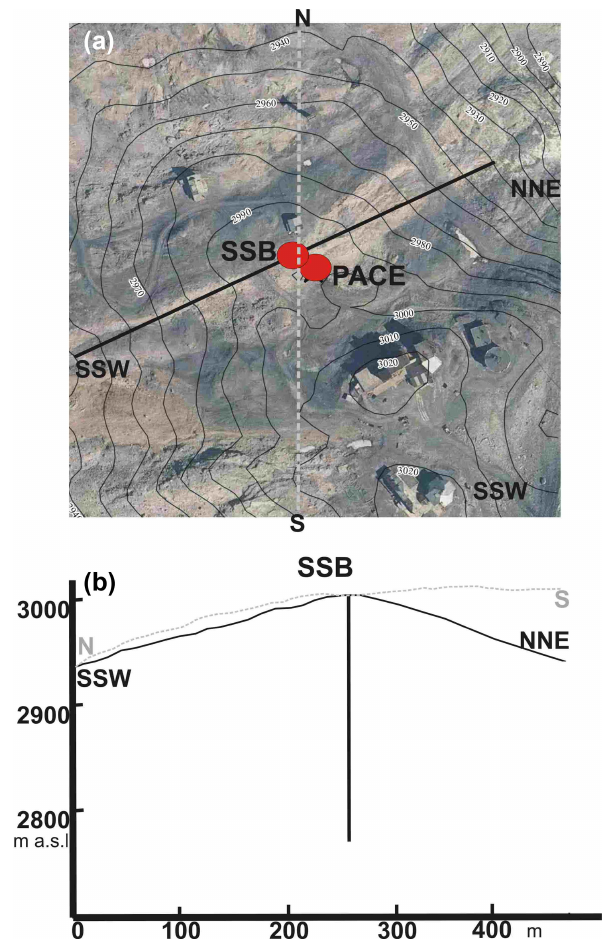
Figure 2. Topography of the SSB site: (a) digital elevation model (5m resolution) of the SSB site and (b) SSW–NNE (solid line) and N–S (dashed line) transects through the Stelvio summit. Horizontal and vertical scales as well as thermistor chain position and depths are plotted to the same